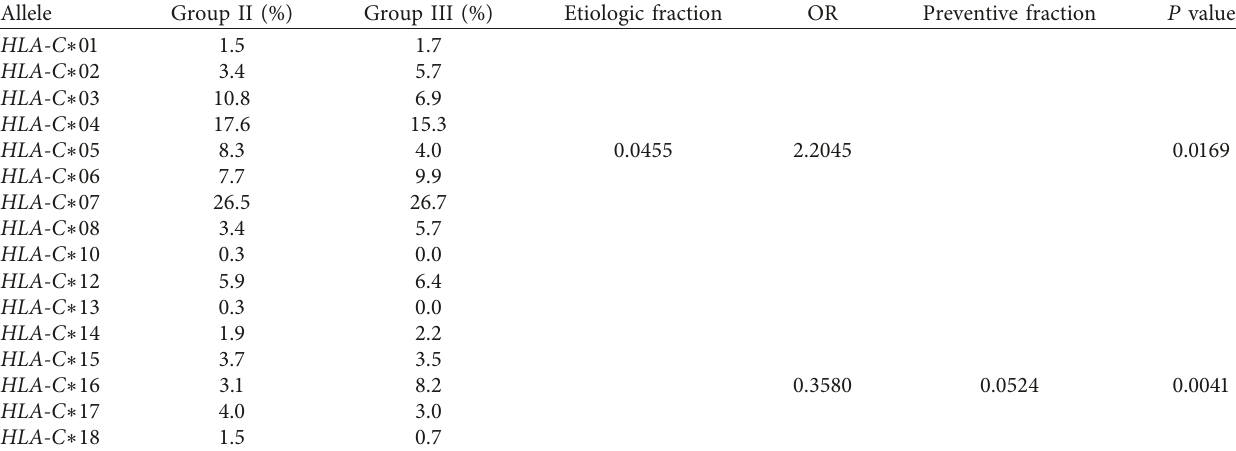
Table 3: HLA-C allele frequencies compared between Groups II (patients with AIDS without CR) and III (healthy HIV-negative